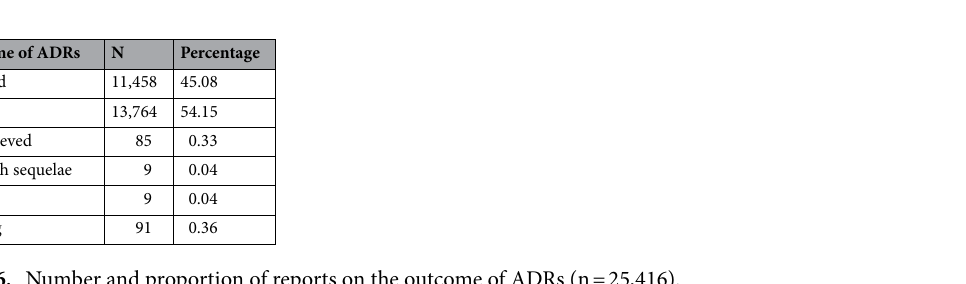
Table 6. Number and proportion of reports on the outcome of ADRs (n =